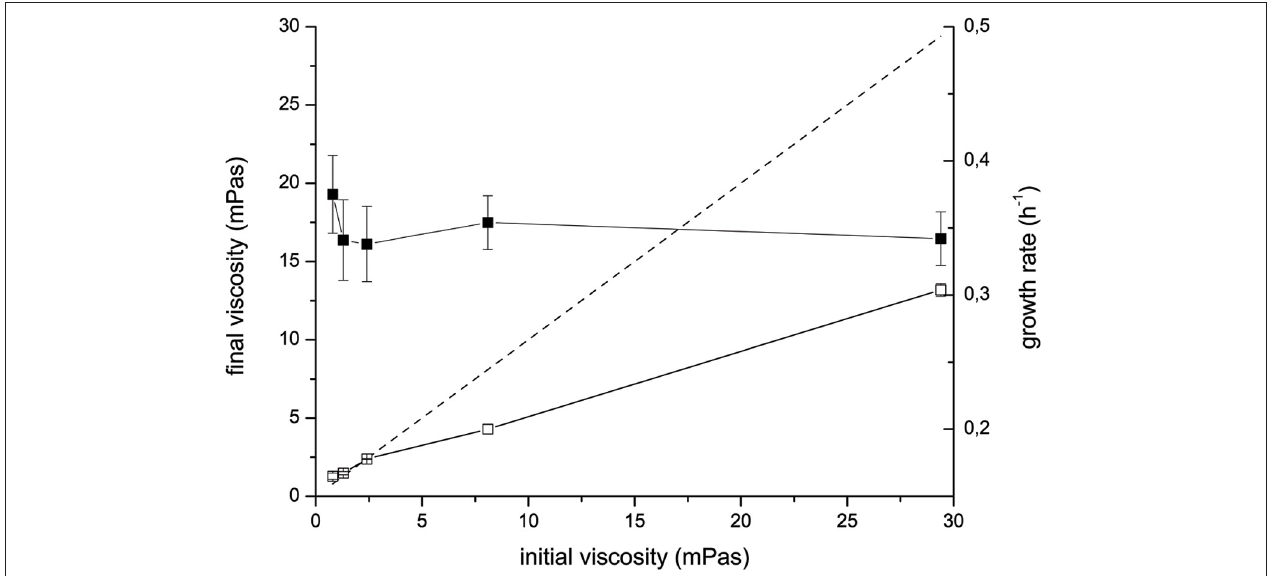
FIGURE 1 | Changes of viscosity of the M9 medium supplemented with HEC incubated with V. ruber (open symbols) and without V. ruber (dashed line). Viscosities were measured at the beginning